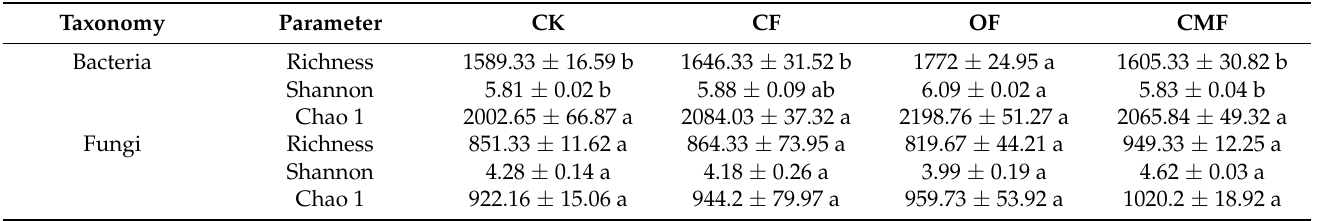
Table 2. Richness, Shannon, and Chao 1 indices of the bacterial and fungal community under four fertilizer treatments.